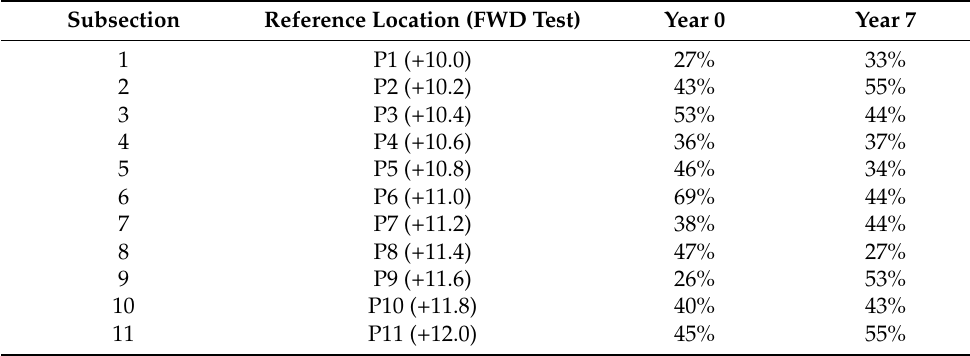
Table 4. Coefficients of Variation (%) for the IRI at the right wheel path (RWP). Subsection